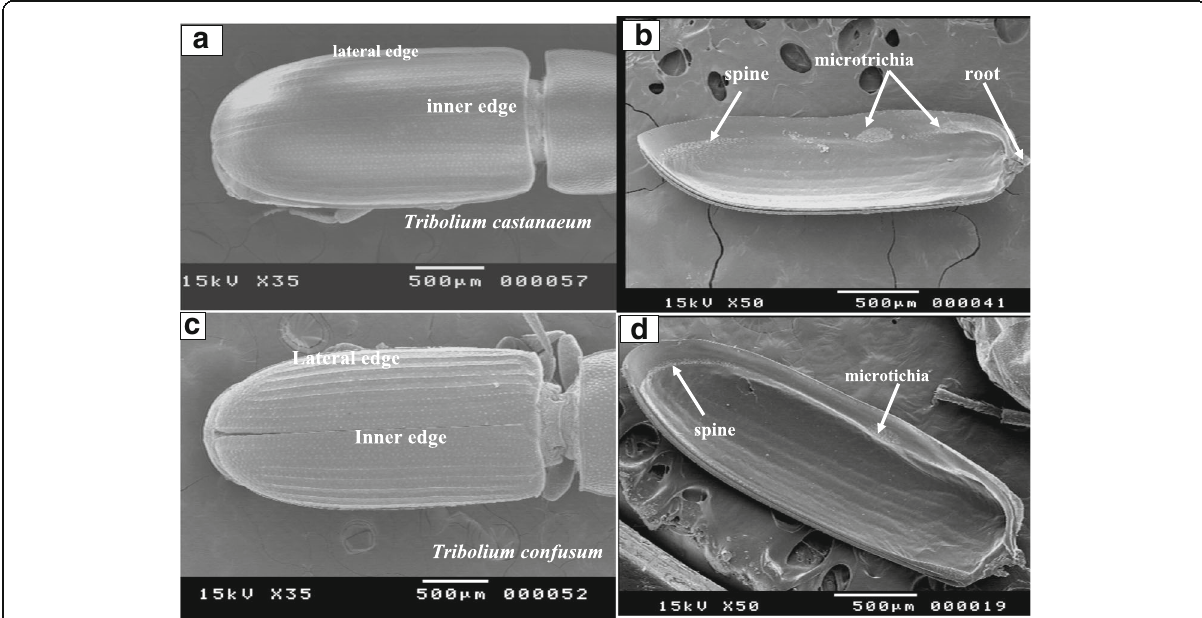
Fig. 1 Scanning electron microscope (SEM) images of Tribolium elytral morphology. a dorsal view and b ventral view Tribolium castanaeum . c dorsal view and d ventral view Tribolium